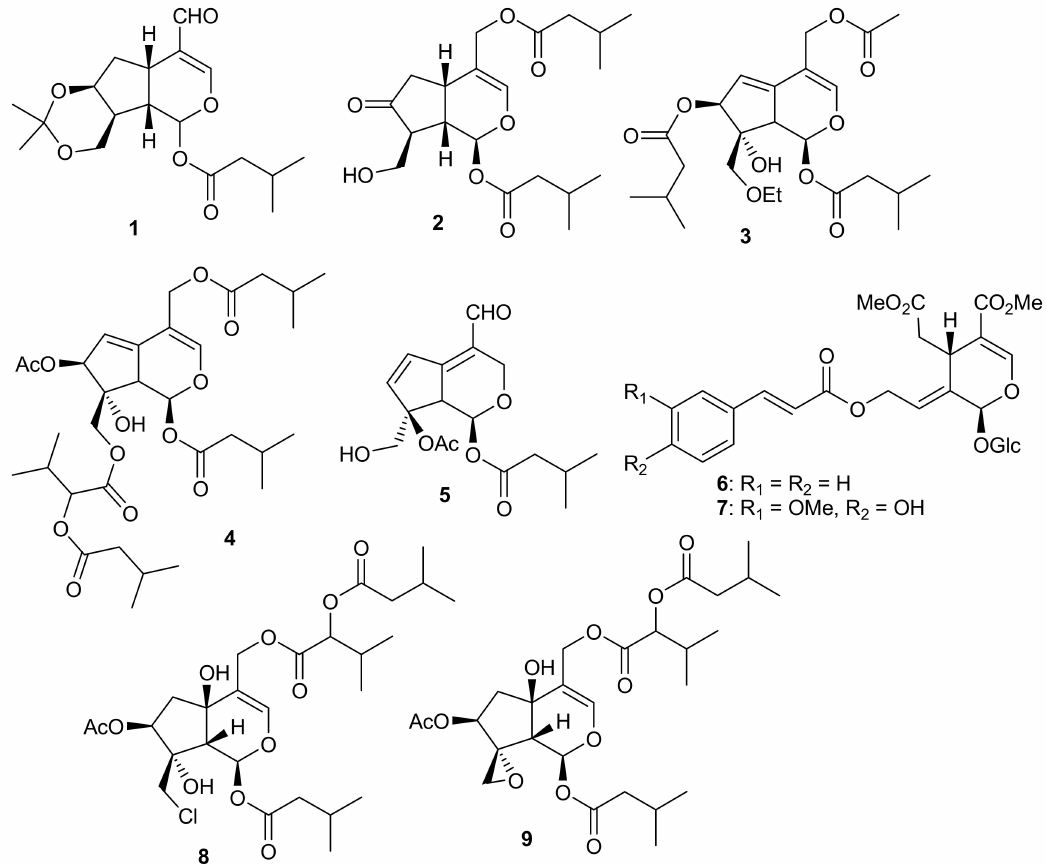
Figure 3. Structures of cytotoxic iridoids 1 – 9